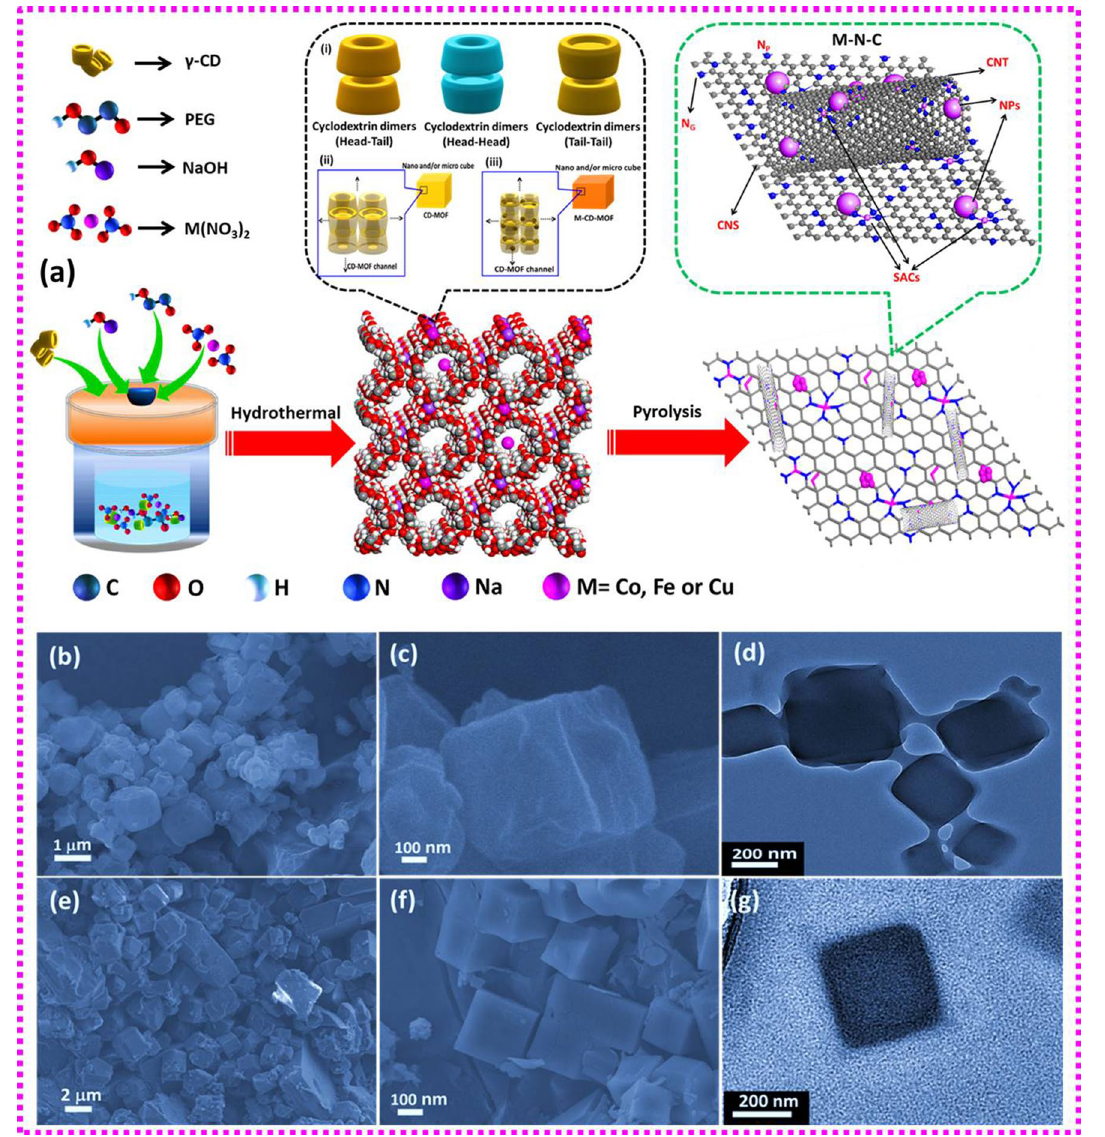
Fig. 1 a Schematic of the preparation of the bare CD-MOF, M-loaded CD-MOFs, and the M–N–C catalysts, in which the insets are: (i) three possible orientations for CD dimers (HH, HT, and TT); (ii-iii) Proposed formation mechanism based on molecular dynamics notion and experi- mental results for CD-MOF and M-CD-MOF nanostructures through the γ-CD channel growth; FE-SEM and TEM images of: b‑d bare CD-MOF and e–g